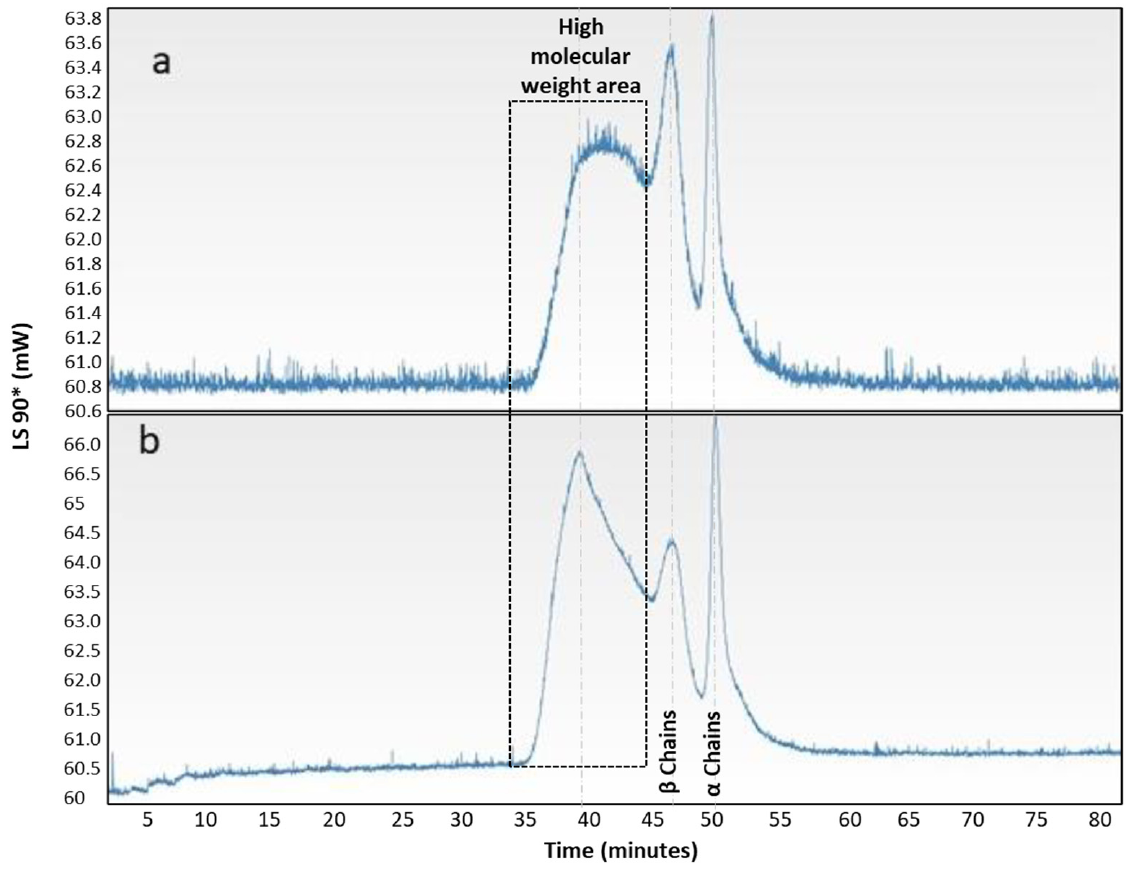
Figure 9. GPC curves for ( a ) 4% wt_15 y ( b ) 4% wt_10 .